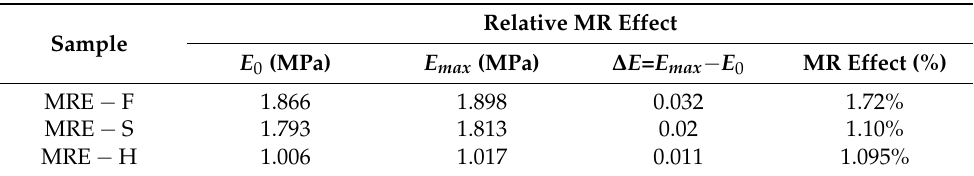
Table 4. The zero-field modulus, magneto-induced modulus, and relative MR effect of MRE-F, MRE-S, and